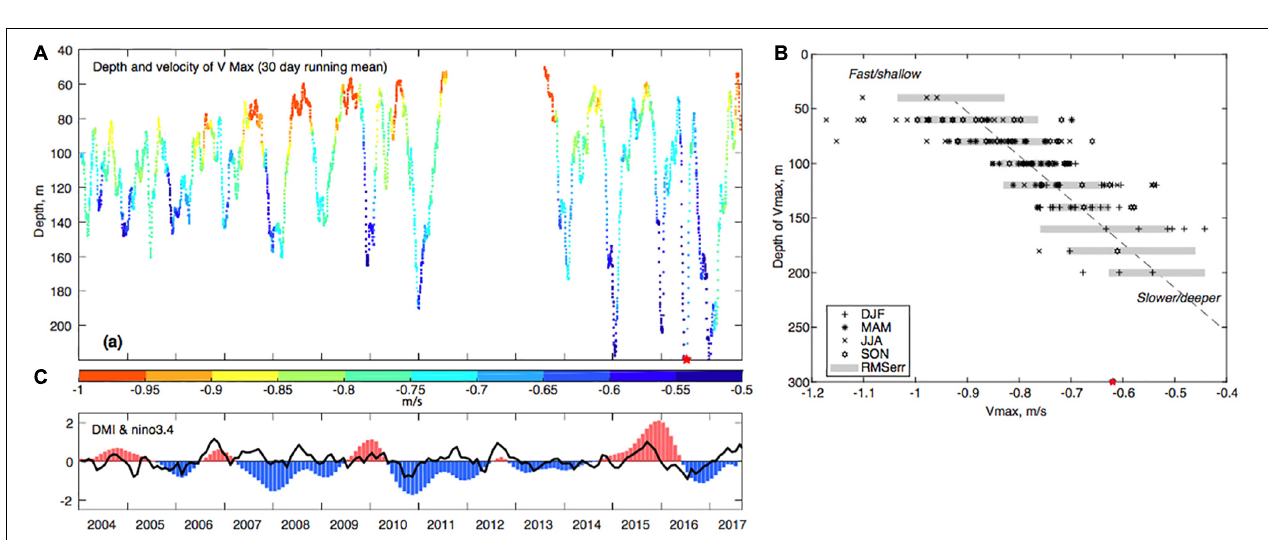
FIGURE 2 | Time series of currents (m/s; 30-day running average), from ∼ 50 to 450 m depth, along the axis of Labani Channel of Makassar Strait. Red colors are toward the south (Indian Ocean), blue colors to the north (Figure from Gordon et al., 2019).